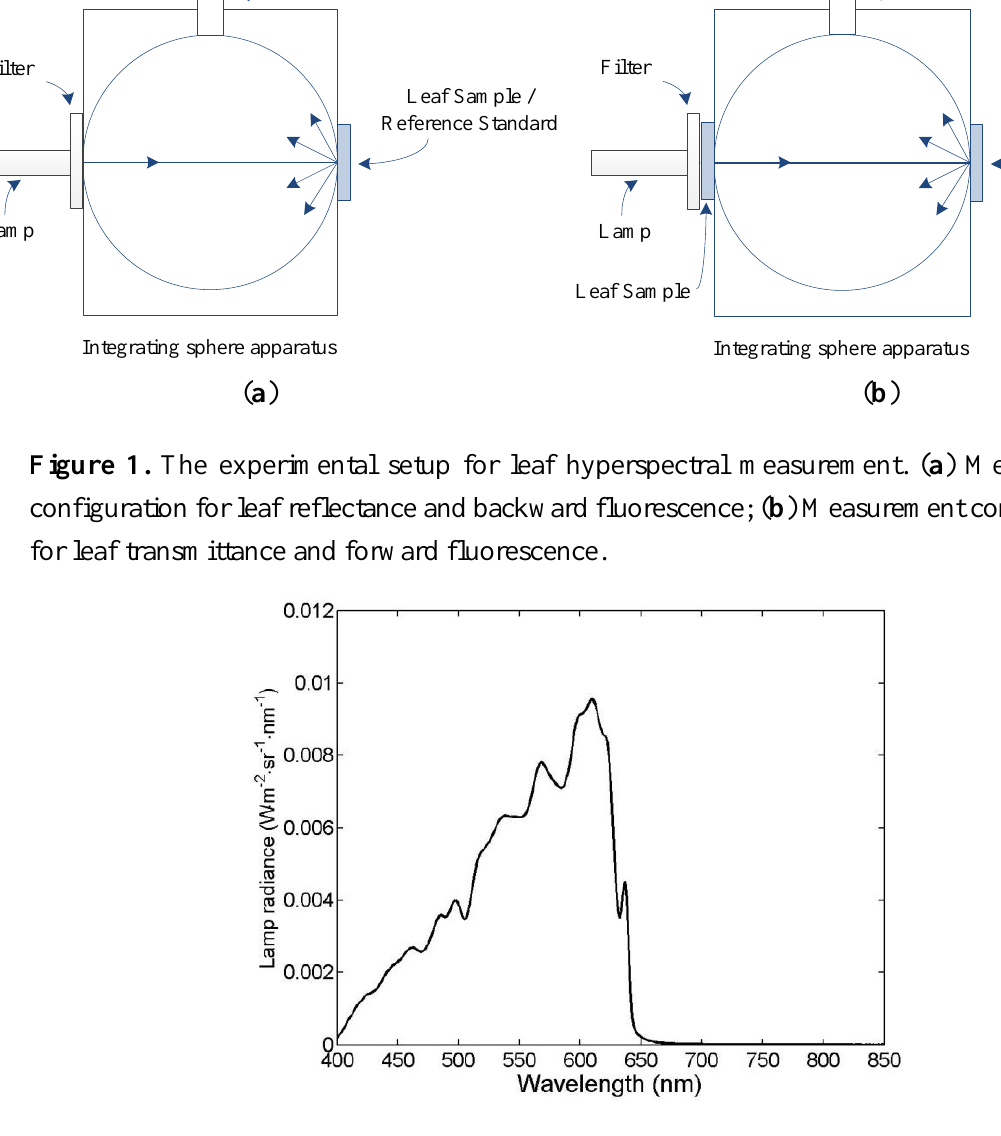
Figure 2. An example of radiance distribution of the lamp with the short-pass